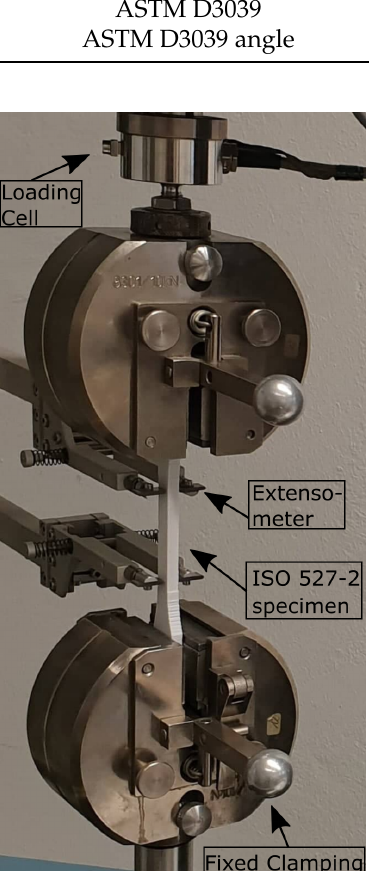
Figure 4. Initial state of an ISO 527-2 specimen clamped into a Zwick 1446 testing device with an extensometer (left) and a loading cell (top). One mounting side is fixed (bottom), while displacement is applied vertically through the upper mounting